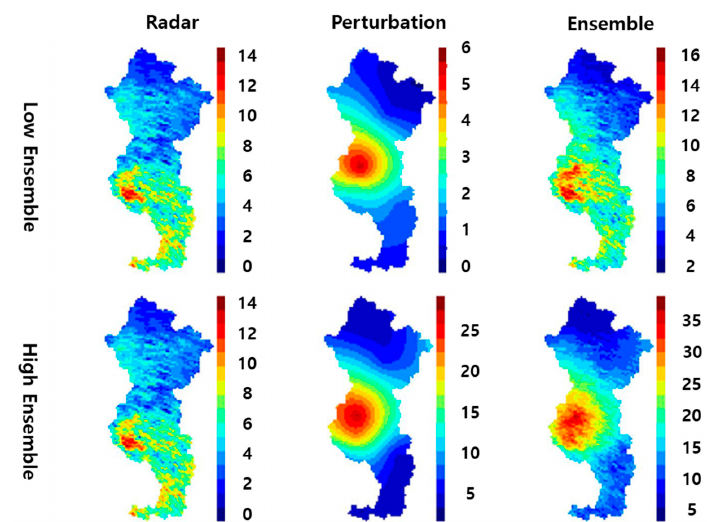
Figure 7. An example of the generated ensemble rainfall—13 July 2013 06:00.